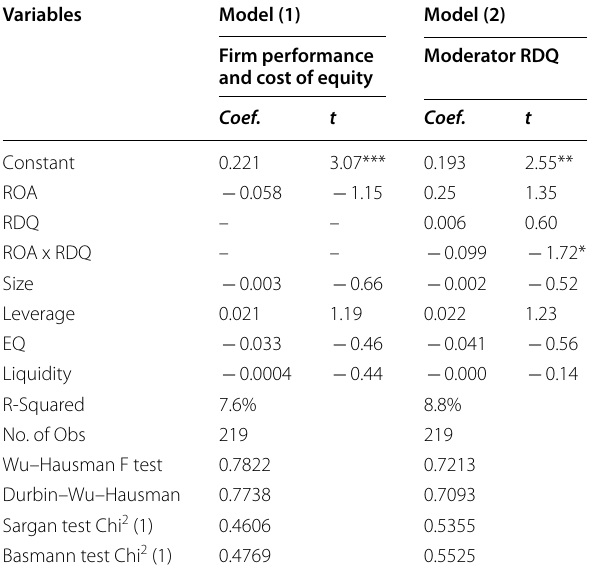
Table 6 2SLS Results for models (1) and (2)